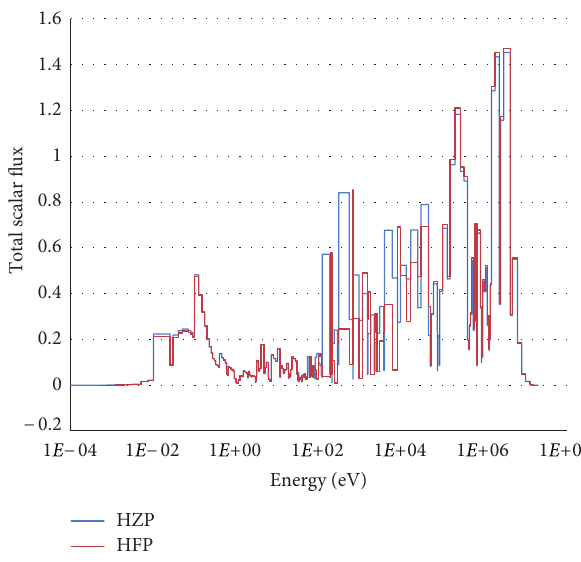
Figure 1: The neutron flux of PWR unit cell at two different operating